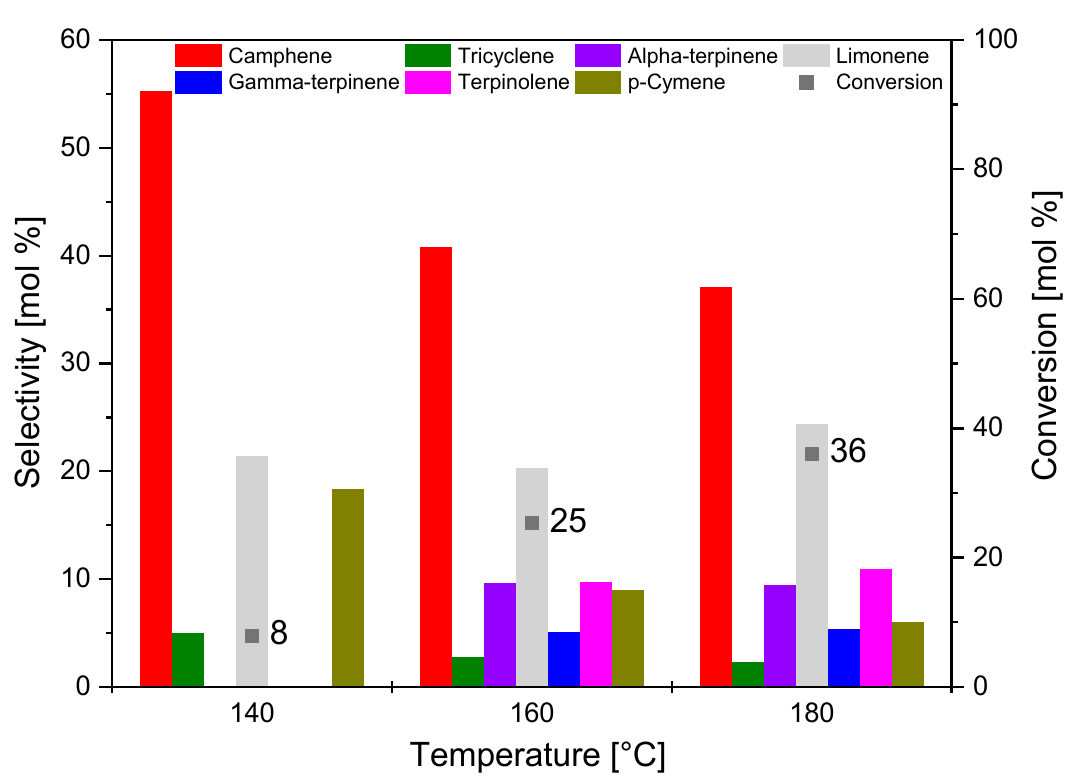
Figure 12. Comparison of the selectivity of the main products and the conversion of organic raw material (alpha-pinene) at different temperatures after 3 h for the S_AC sample.